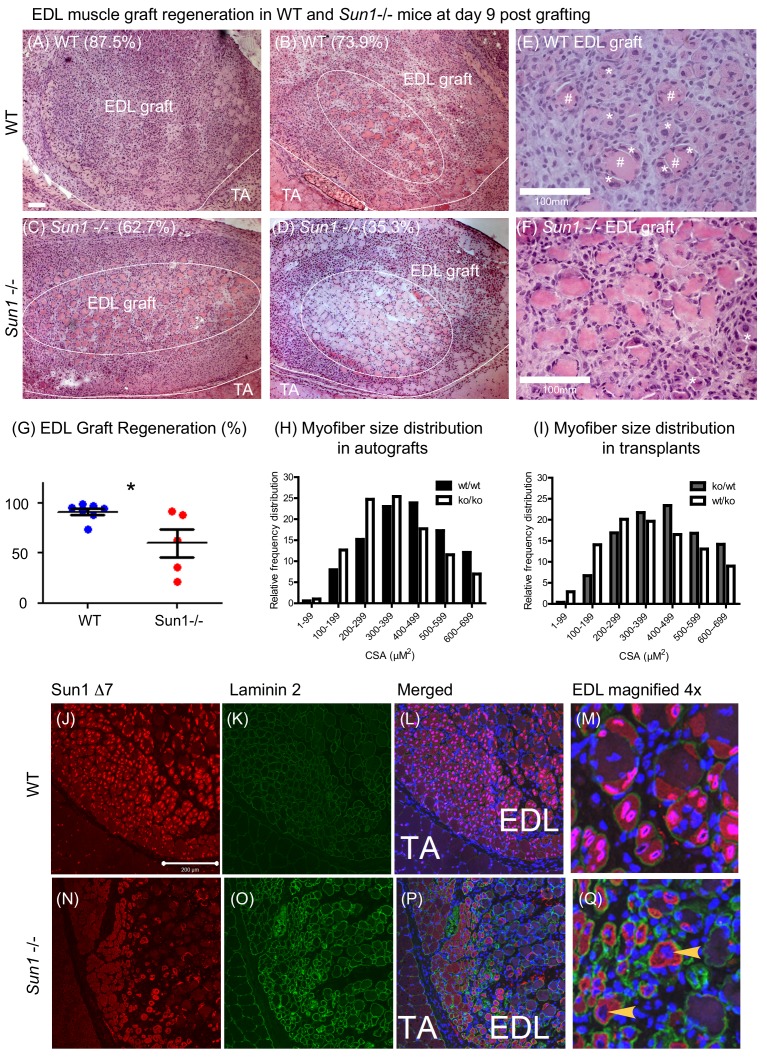
Loss of SUN1 retards muscle regeneration.(A) Haematoxylin and eosin (H and E) stained images of EDL grafts at day nine post engraftment. In the WT grafts (A and B) and Sun1–/– grafts (C and D) the central necrotic muscles are demarcated by a white oval, with the boundary of the EDL graft and TA muscle being marked with a white line. Scale bar, 100 μm. (E) Magnified view of necrotic muscle fibers (#), with regenerating myofibers (*) clustered around the necrotic muscle and clusters of regenerated muscle fibers (*) in the WT EDL graft. (F) Myogenesis had initiated at the Sun1–/– /– periphery (*), however the core area was occupied with necrotic muscle fibers. (G) Comparison of muscle regeneration between WT (n = 7) and Sun1–/– (n = 5) mice. The numbers are expressed as a percentage of newly regenerated myofibers over total muscle numbers in the graft, with mean ± SEM and *p<0.05. Percentage of regeneration is included (in parenthesis) in the H and E images. (H and I) The cross sectional area (CSA) of the regenerated myofibers in both autografts and reciprocal grafts were quantified and presented in CSA distribution curves. (J) SUN1 Δ7 and - Δ7, Δ9 isoforms localize to the NE of regenerating EDL myofibers in vivo. Images (red immunostaining) of (top panel) SUN1 Δ7 at the nuclear envelope (NE) of WT muscle fibers; (K) laminin 2 (green) staining defines the boundary of individual myofibers and (L) with DAPI staining to mark the nuclei. (M) Sun1 Δ7 and - Δ7, Δ9 isoforms (red immunostaining) are expressed in regenerated muscle myofibers NEs (defined by the green laminin staining), with the isoforms being absent in surrounding non muscle cell nuclei (blue). (Q) In the Sun1–/– grafts the Sun1 Δ7 antibody did not stain the NE of regenerated muscle myofibers (as defined by the green laminin staining and yellow arrowheads), (bottom panel). The red cytoplasmic signal in myofibers is non-specific probably due to cross-reactivity by the polyclonal antibodies. Scale bar, 200 μm.